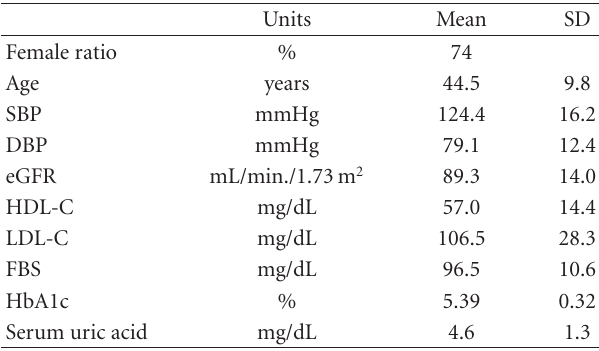
Table 1: Basic characteristics of the